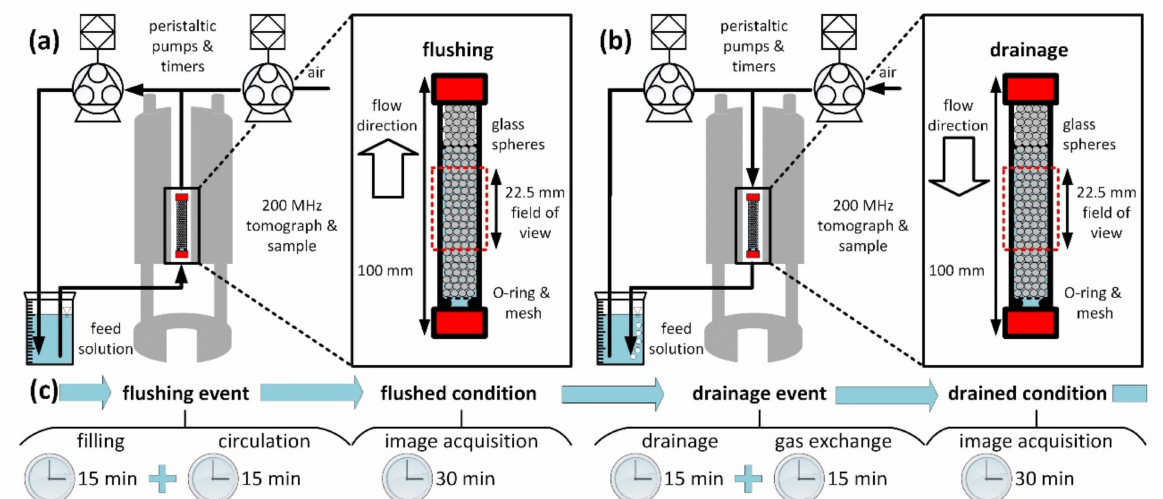
Figure 1. Experimental setup of the MRI experiments. Flushing ( a ) and drainage ( b ) events were conducted in alternating order. The timing of work flows is highlighted in ( c ). In the flushed and drained conditions, both pumps were turned off to acquire images in a static